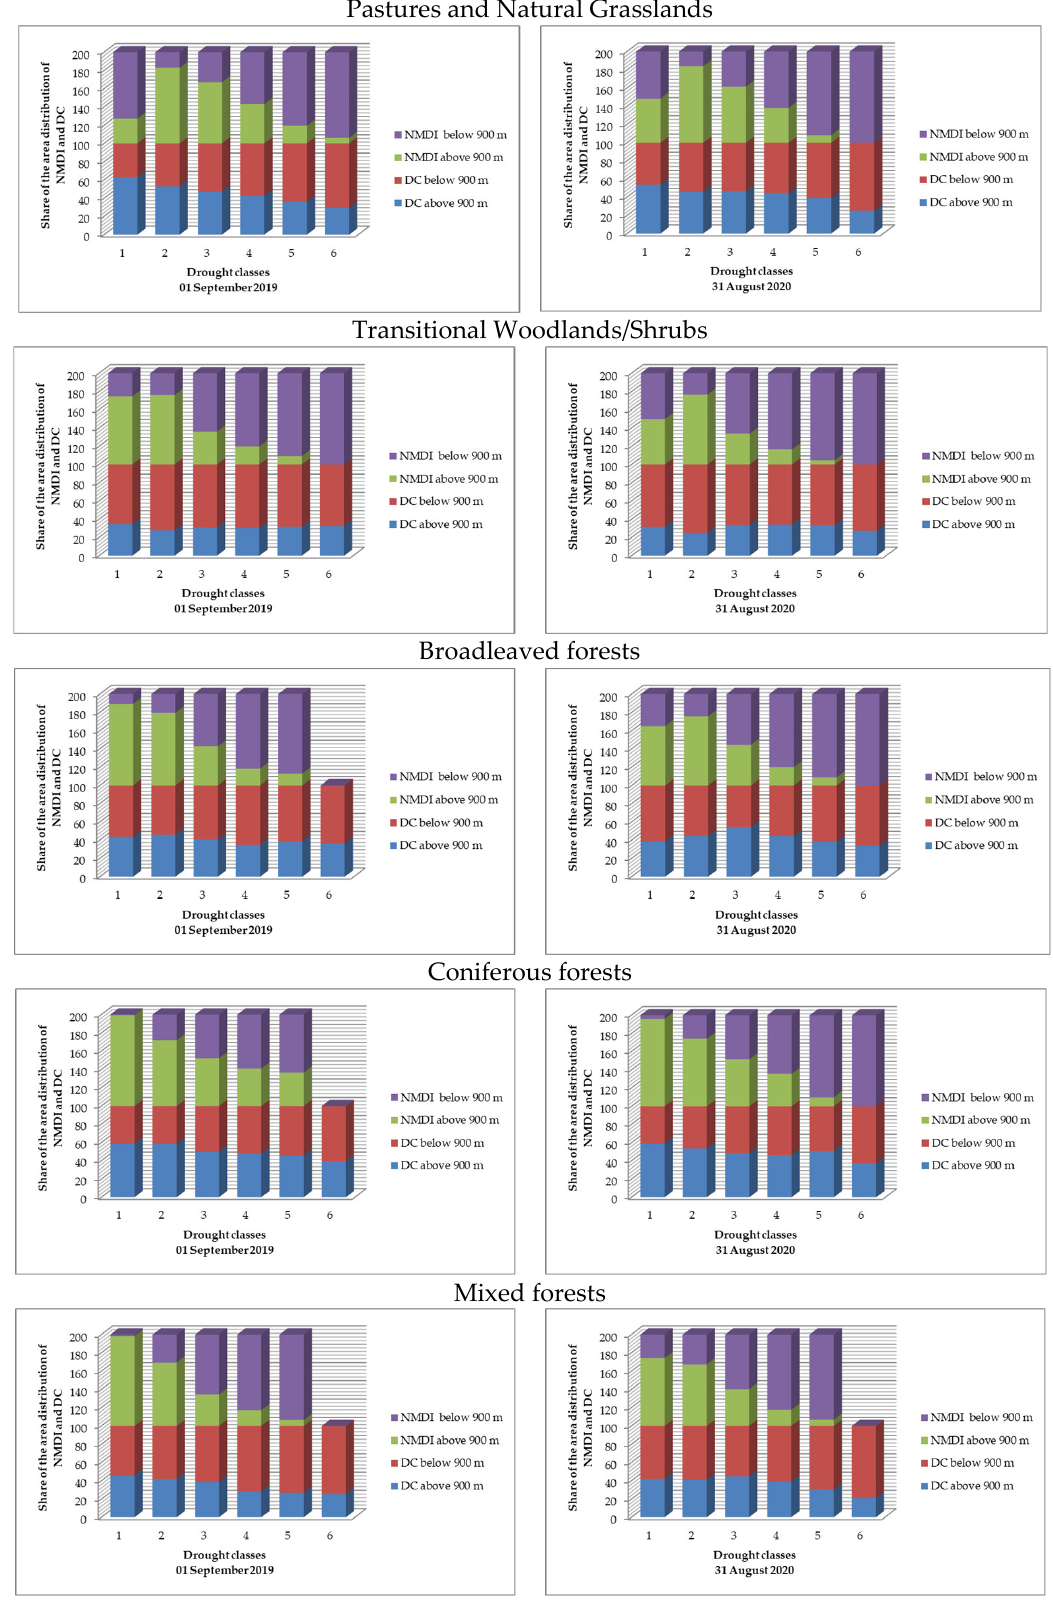
Figure 13. Share of the area of distribution (in %) of the Normalized Multi-band Drought Index (NMDI) and the Drought coefficient (DC) for the different land cover classes (LCCs) above and below 900 m. a.s.l. in the studied area.